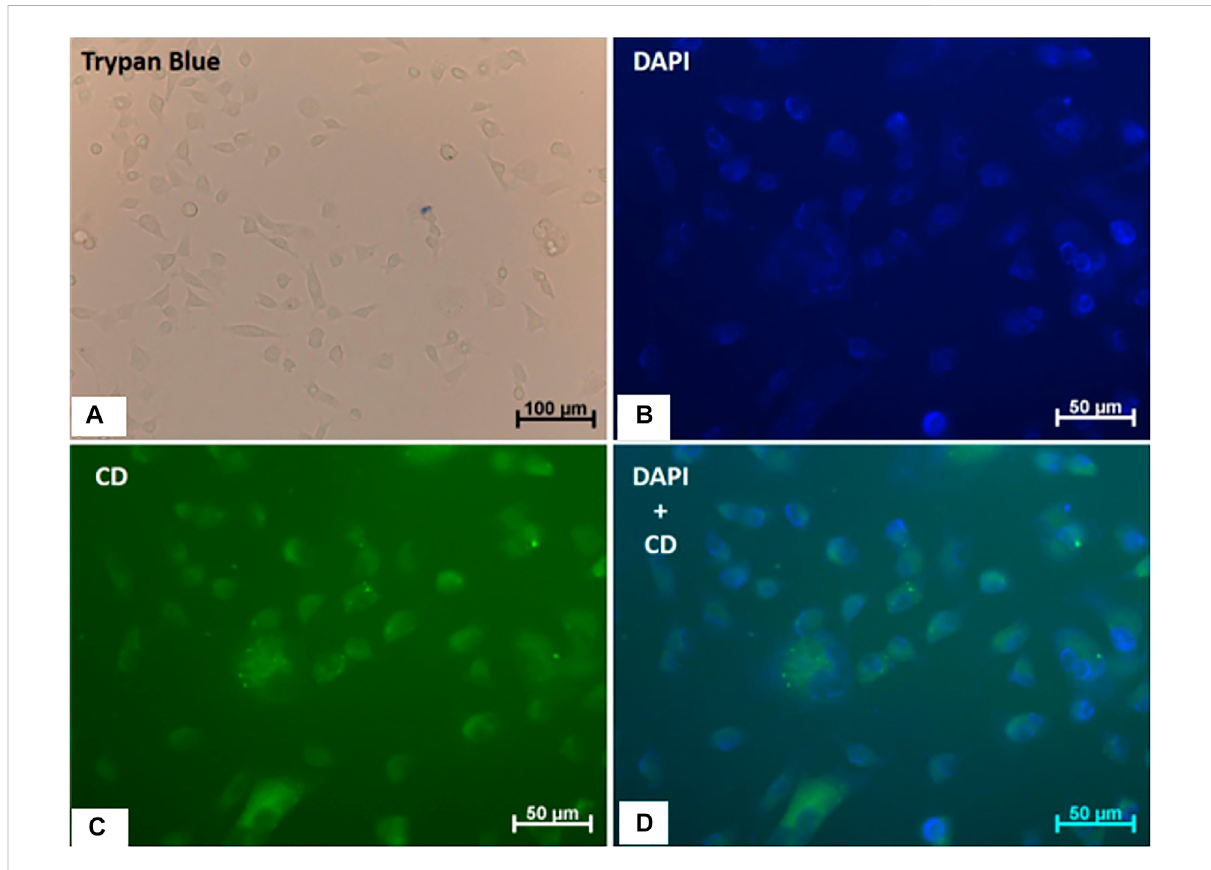
FIGURE 9 Viability, morphology and internalization of CQD a by human endothelial cells (EA.hy926). (A) Trypan blue staining; the scale bar is 100 µm. (B) DAPI staining. (C) Fluorescence of cells treated with CQDs (0.4 mg/ml) for 1 h. (D) Merged images (DAPI + CQD). The scale bar is 50